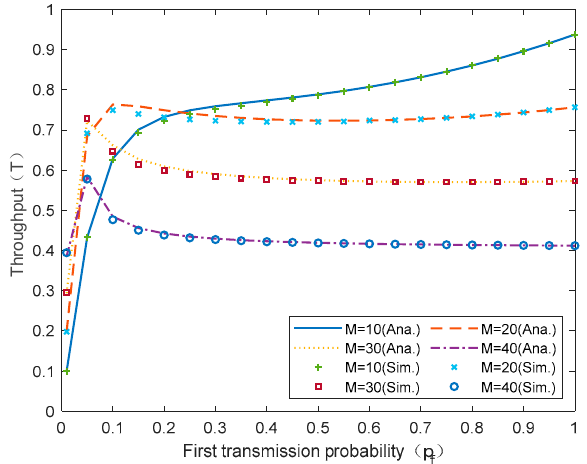
Figure 9. Throughput vs. first transmission probability (Ana. vs. Sim.).